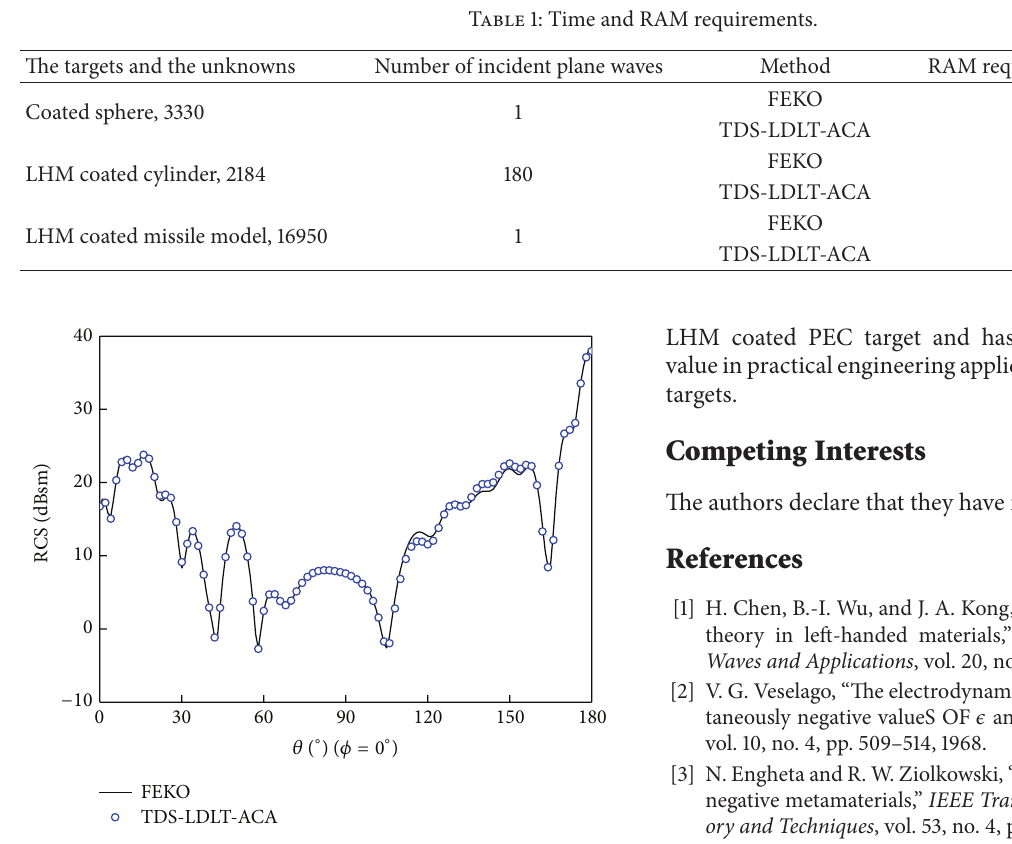
Figure 6: Bistatic RCS of LHM coated PEC missile model.